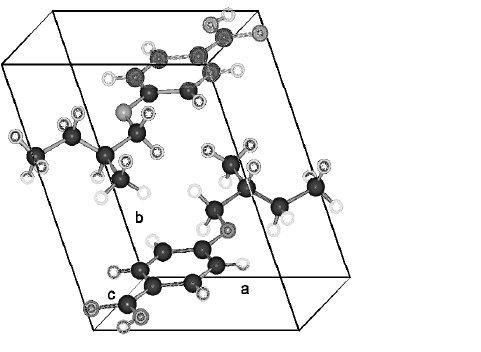
Figure 9. Representation of packing arrangement of a 1:1 racemic mixture of ( R , S )-MBOBA in two projections. The asymmetric unit of space group P-1 contains one molecule, which is related by an inversion center to a second one through strong hydrogen bonds to form a dimer as shown in Figure 8. The projection down the dimeric axes leads to strings arranged in planes.